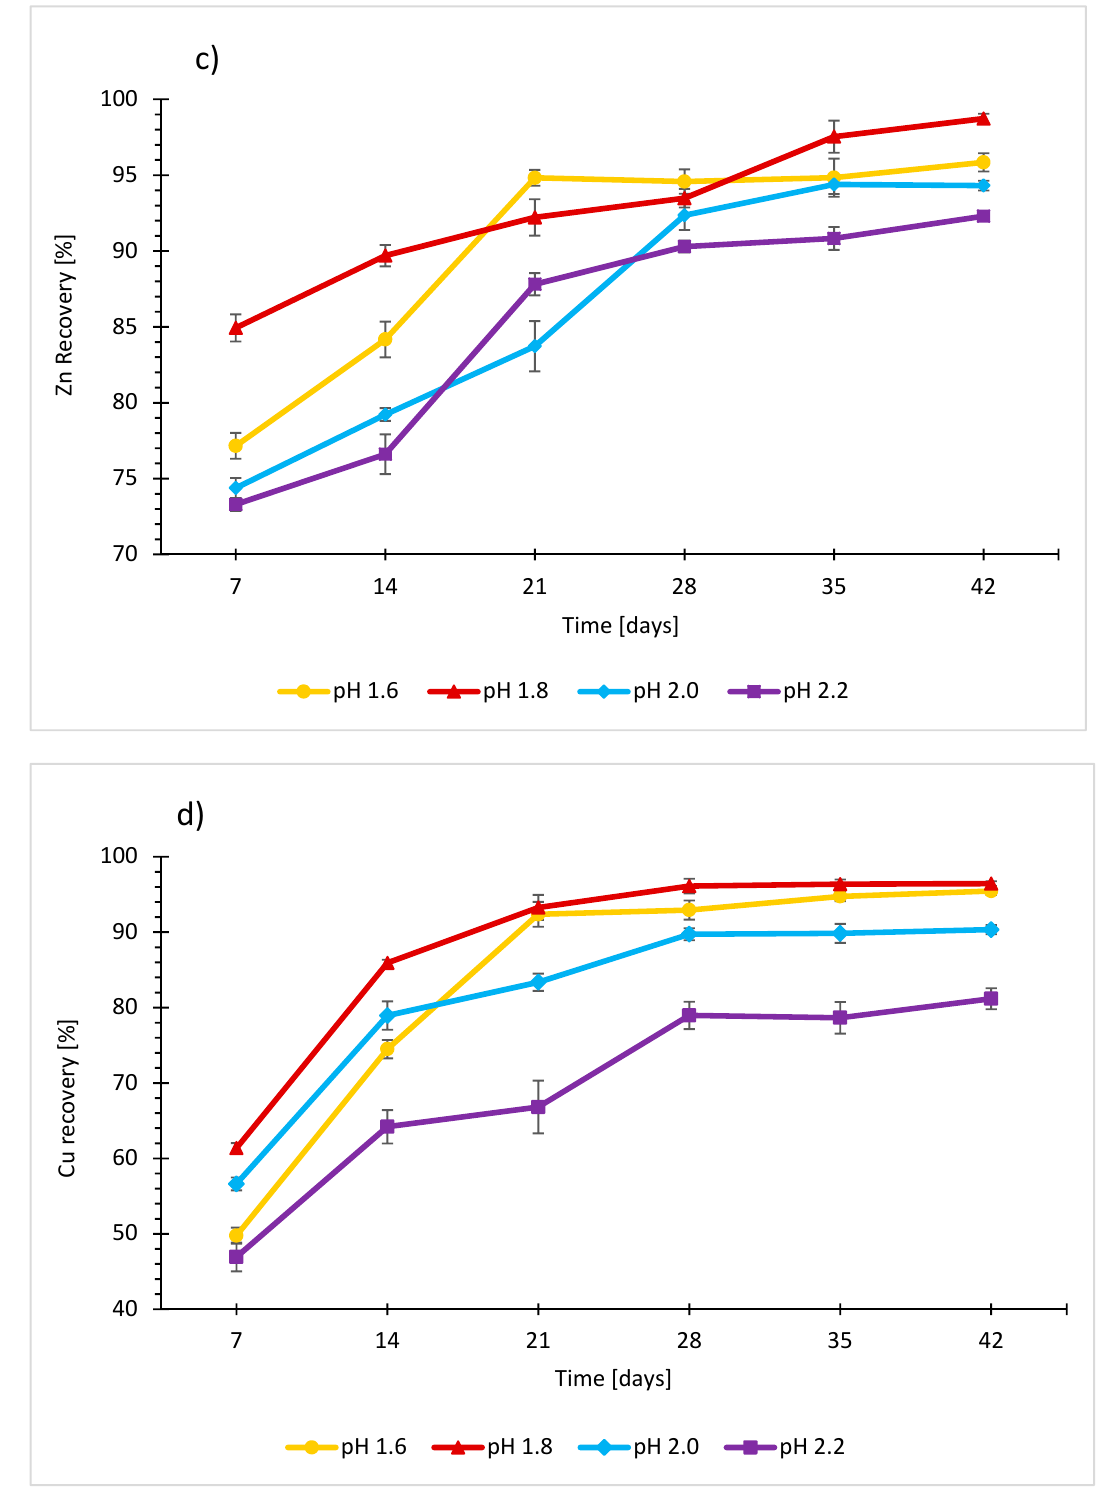
Figure 13. Dependence of the percentage of dissolved metal on time at differential pH values for Fe ( a ), Pb ( b ), Zn ( c ), and Cu ( d ).